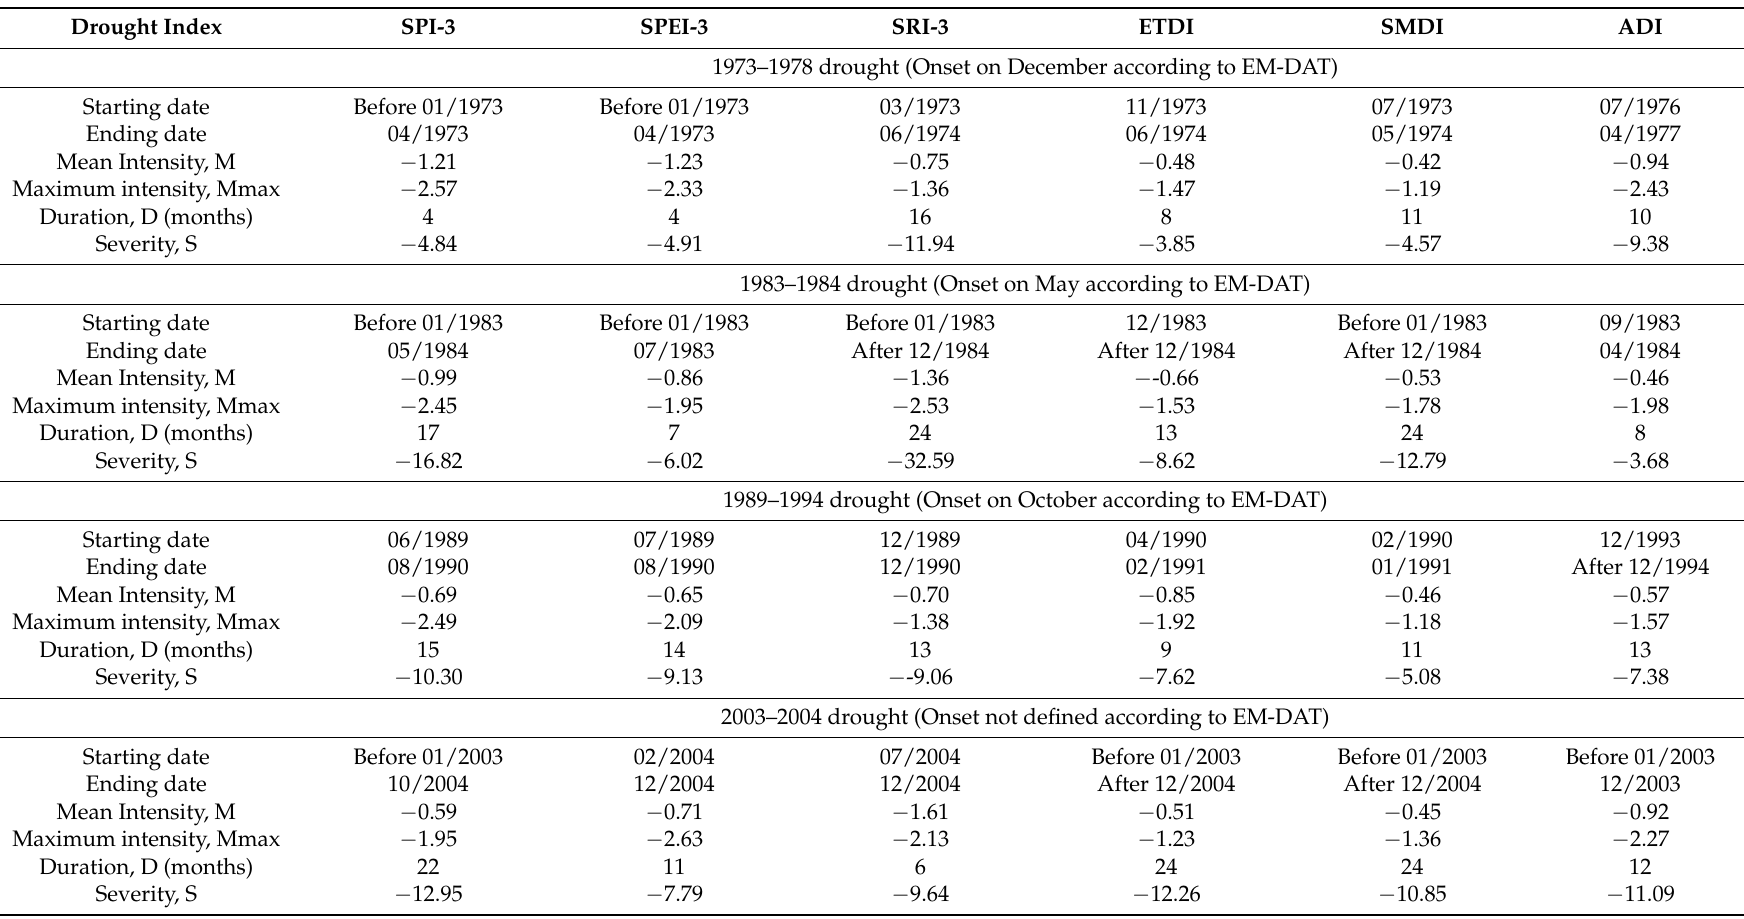
Table 8. Characteristics of the historic drought events as identified by the six drought indices for the Upper Blue Nile basin upstream of Bahirdar. Note that if the index indicated the onset to be before January of the reported calendar year of the historic drought, this is presented in the table with “before” and if, according to the index, a drought extended beyond December of the reported calendar year, this is presented with “after”. The drought duration in these cases is based on a start in January and an end in December of the reported drought